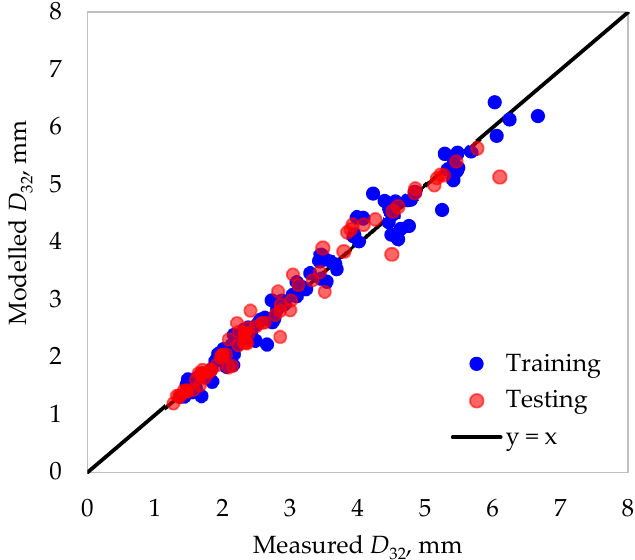
Figure 5. Measured versus modeled Sauter diameters: training and testing datasets, after removing abnormal conditions.